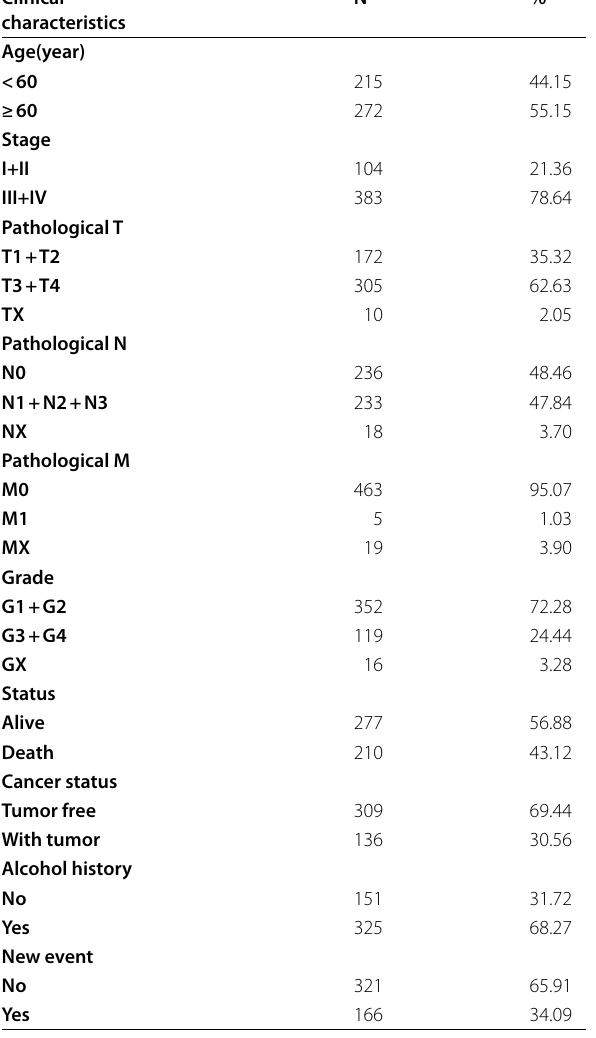
Table 2 The list of gene sets ERS-related